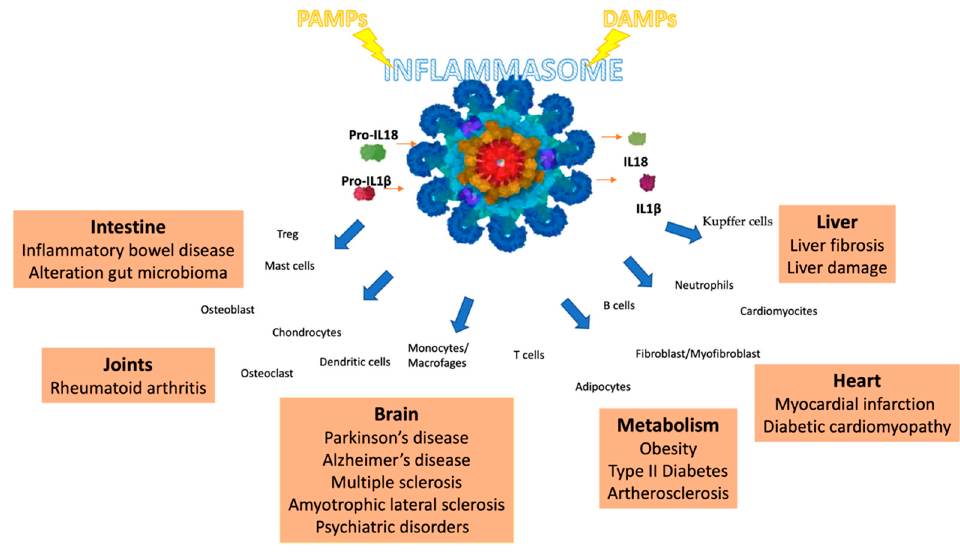
Figure 2. An overall summary of the NLRP3 inflammasome in pathologies.